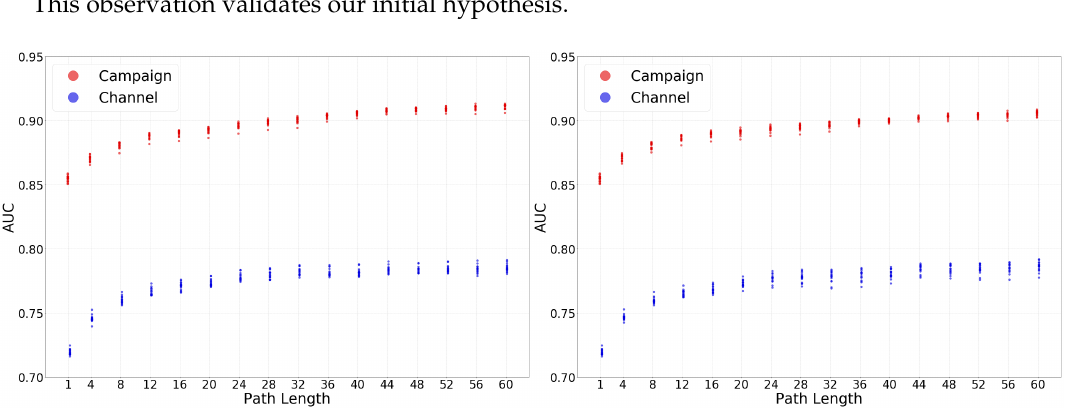
Figure 6. Comparison of the accuracy in the linear model for the campaign granularity against the channel granularity. On the left side we have the aggregated frequency and on the right the disaggregated frequency. Preferably see it in